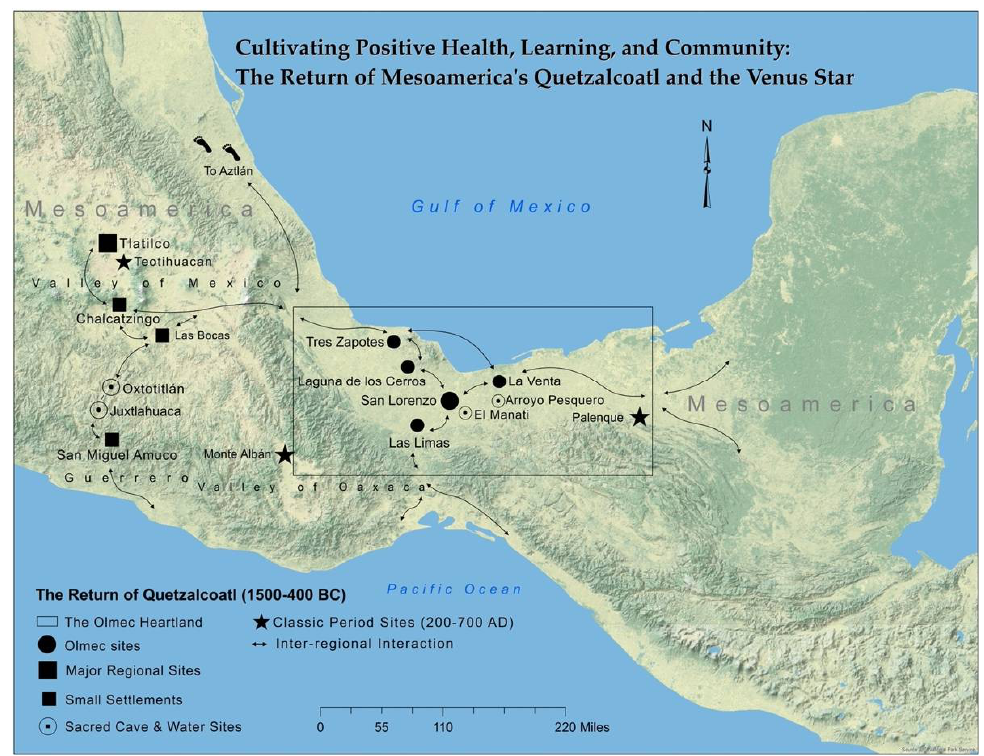
Figure 6. During the Formative period (1500–400 BC) the return of Quetzalcoatl involved a multi- regional network of wing-serpents, accountabilities, and the exchange of medicine. Best described as a healthcare movement, through inter-regional interaction people exchanged an assortment of portable and precious objects. Taking advantage of archaic trading routes, they effectively traveled prolonged periods and fulfilled local and regional responsibilities. Along the way, they left offerings at sacred sites, hunted for survival, and gained a keen understanding of the land and cosmology. Quetzalcoatl, in the role of medicine man, artisan, and custodian of the land, offered spiritual guidance, comfort, and traditional healing ways. This story informs all Indigenous peoples of the Americas. Regional map showing corridors of human interaction created by 1st author using ArchMap™.